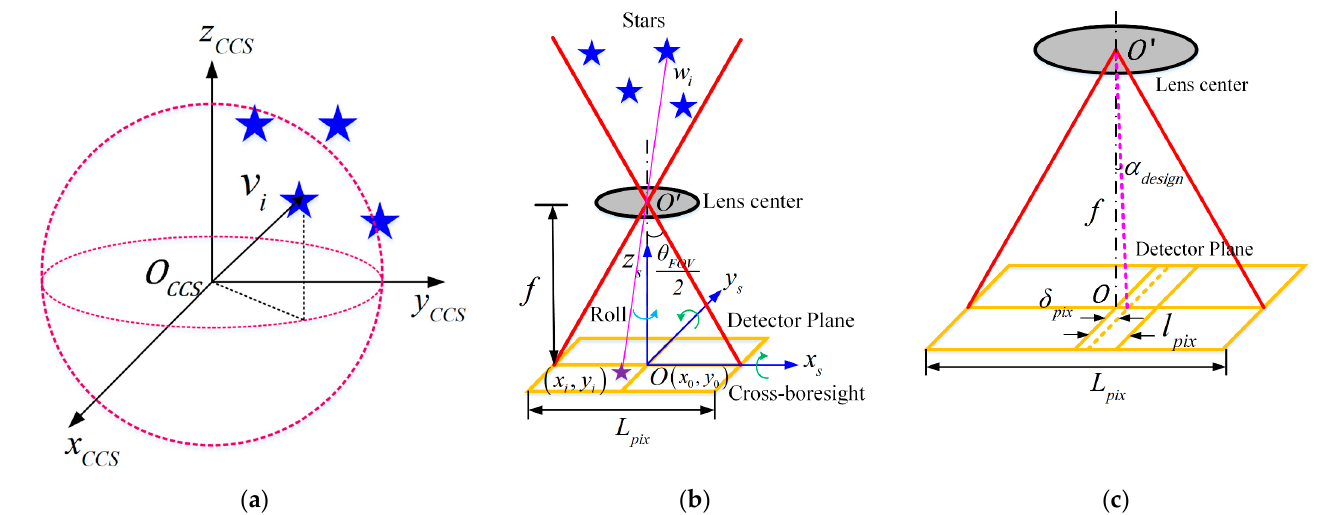
Figure 2 . ( a ) 𝑣 (cid:3036) in the celestial coordinate system. ( b ) Principle of the star tracker and 𝑤 (cid:3036) in the star tracker coordinate Figure 2. ( a ) v i in the celestial coordinate system. ( b ) Principle of the star tracker and w i in the star tracker coordinate system. ( c ) Pointing accuracy model of the star tracker. system. ( c ) Pointing accuracy model of the star